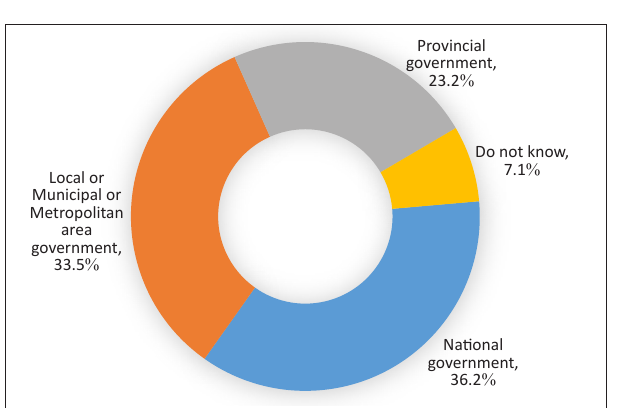
FIGURE 7: Reasons for worsening of local transport.